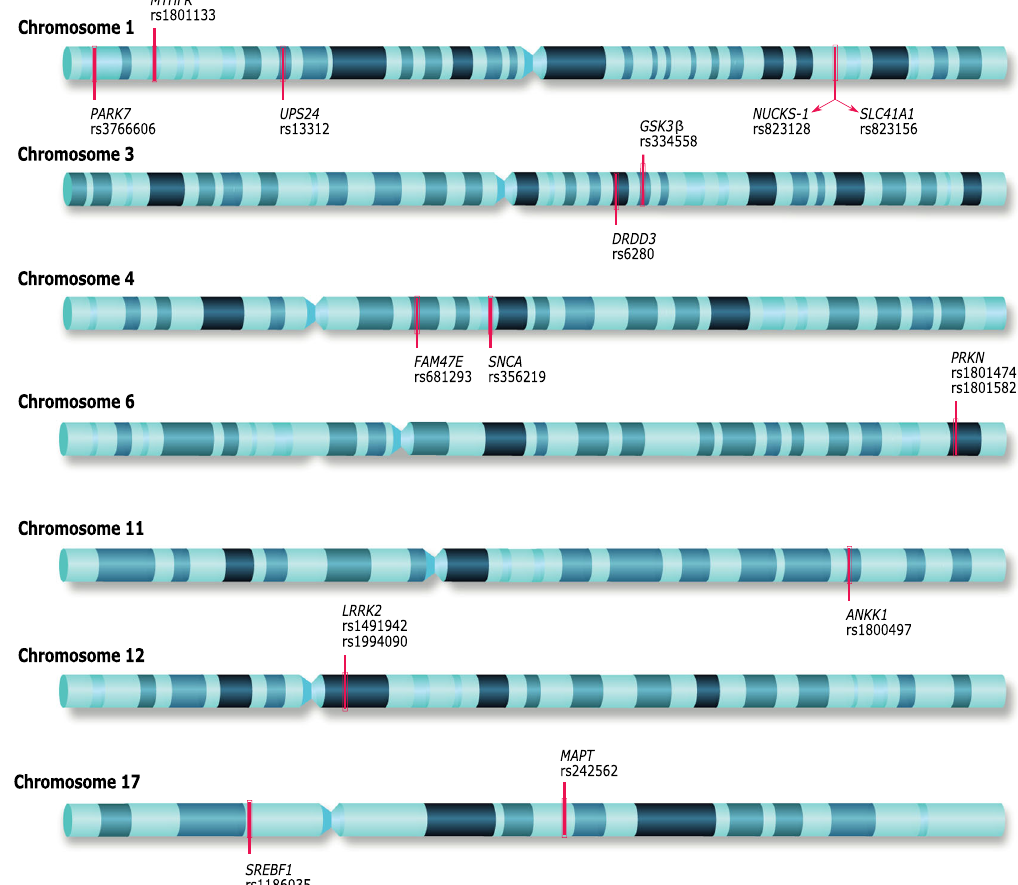
Fig. 1 Chromosomal location of the 16 single-nucleotide polymorphisms selected for this research. Genes symbols and reference SNP numbers. Genes: PARK7 Parkinsonism associated deglycase, MTHFR Methylenetetrahydrofolate reductase; USP24 Ubiquitin speci fi c peptidase 24, NUCKS1 Nuclear casein kinase and cyclin dependent kinase substrate SLC41A1 Solute carrier family 41 member 1, DRD3 Dopamine receptor D3, GSK3B Glycogen synthase kinase 3 beta, FAM47E family with sequence similarity 47 member E, SNCA Synuclein alpha, PRKN Parkin RBR E3 ubiquitin-protein ligase, ANKK1 Ankyrin repeat, and kinase domain containing 1, LRRK2 Leucine-rich repeat kinase 2, SREBF1 sterol regulatory element-binding transcription factor 1 MAPT Microtubule-associated protein